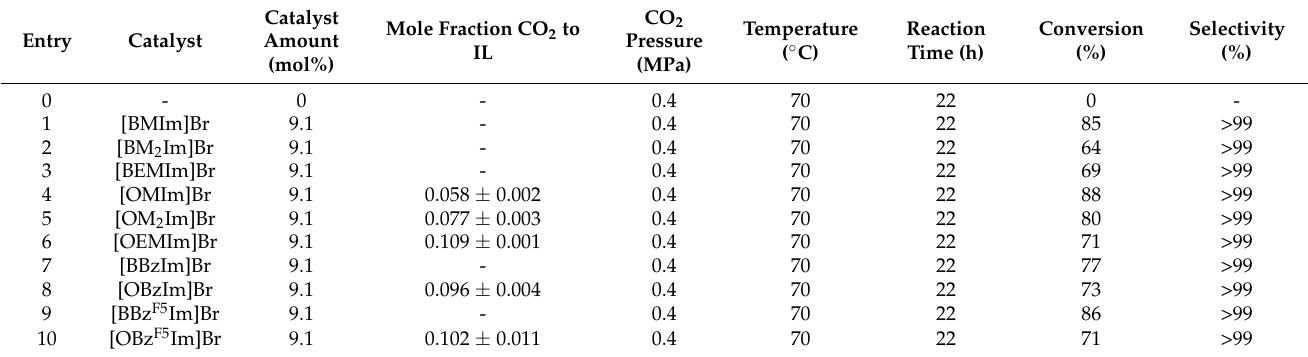
Table 10. Synthesis of PC from CO 2 and PO using IL catalysts [64].